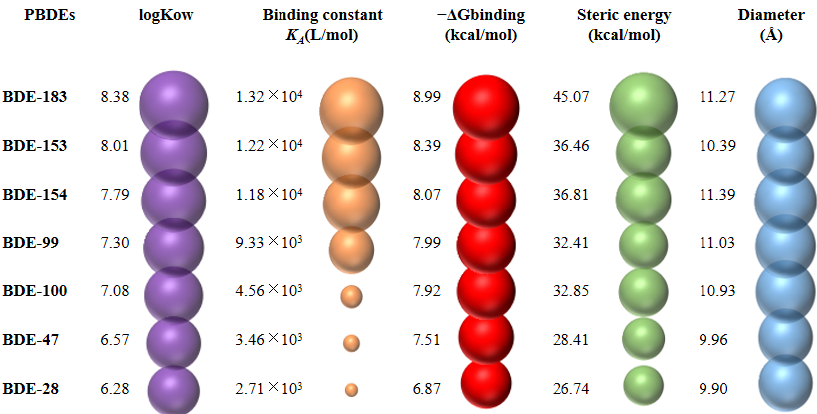
Figure 5. Binding abilities and binding free energies for interactions between PBDE congeners and ovine serum albumin (OSA) and steric hindrance energies for PBDE congeners (bubble width represents data size).